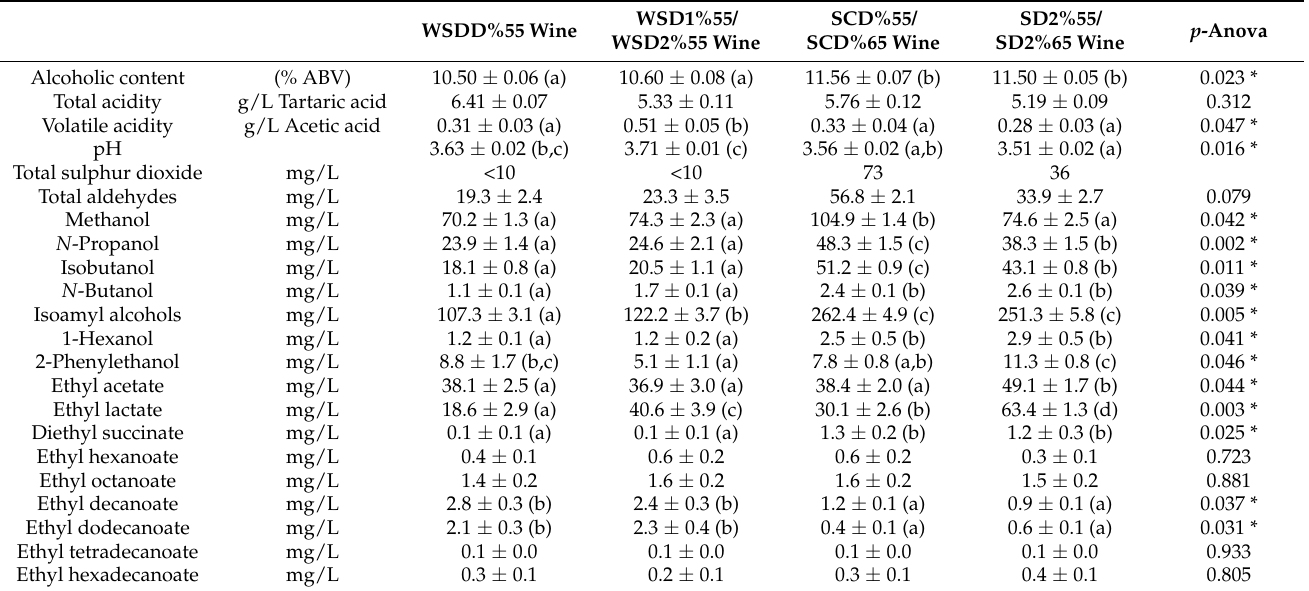
Table 2. Analytical characterization of the wines used for the production of the spirits. A different letter in parentheses indicates a significant-level difference in the sample for p < 0.05 (*). The values are expressed as the mean ± standard